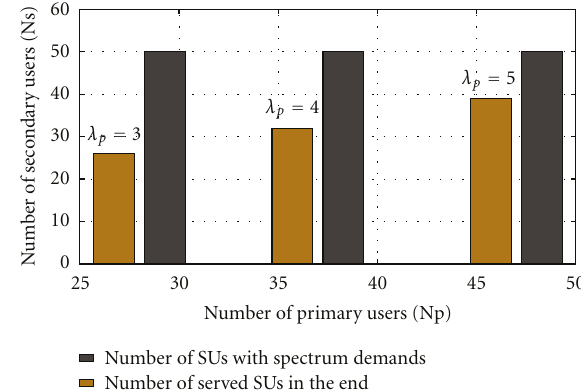
Figure 13: SUs with spectrum demands versus number of served SUs.